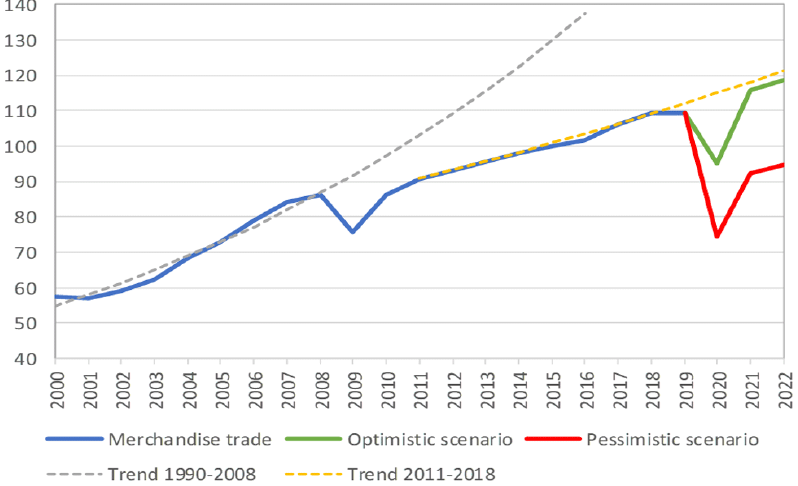
Figure 1. World merchandise trade volume, 2000–2022 Index, 2015 = 100, Source: WTO Secretariat. https://www.wto.org/english/news_e/pres20_e/pr855_e.htm (accessed on 31 October 2020). The graph depicts world merchandise trade volumes, starting in 2000, including optimistic and pessimistic predictions. (It already included predictions of the COVID-19 crisis.) This graph was created by the World Trade Organization, early in 2020; see details in footnote 1.